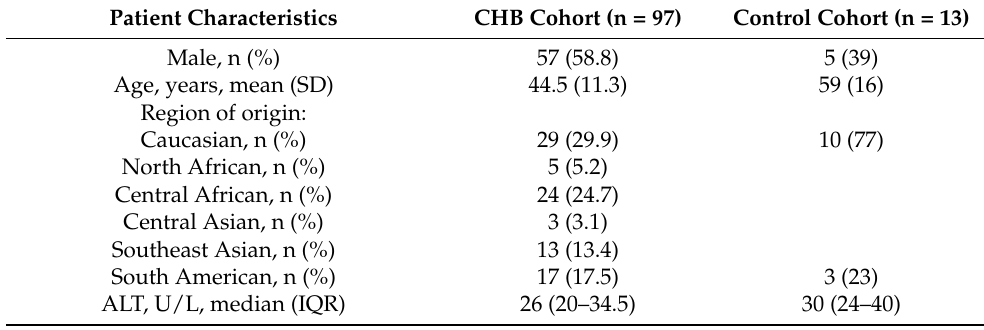
Table 1. Characteristics of the CHB (n = 97) and control liver (n = 13) cohorts. Patient